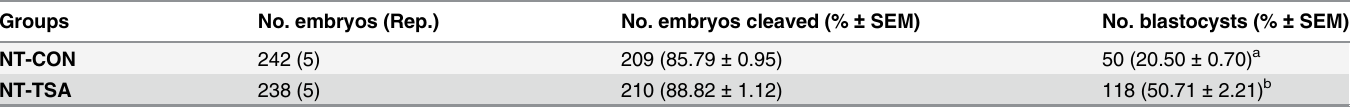
Values in the same column with different superscripts differ signi fi cantly (P <